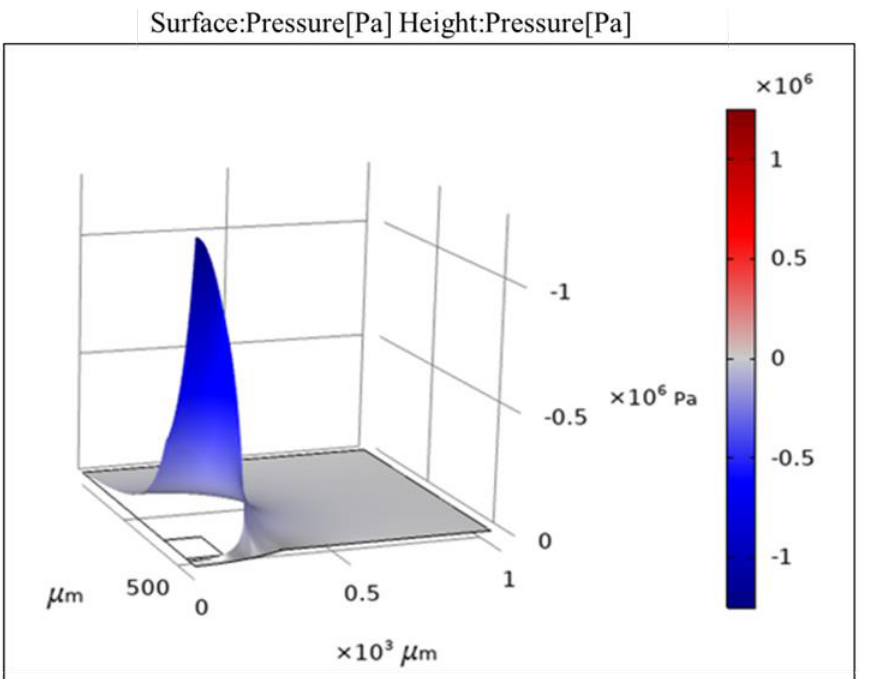
Figure 4. The whole field generated by a device with PI cover for an actuation frequency of 1 MHz and an actuation voltage of 100 V AC.